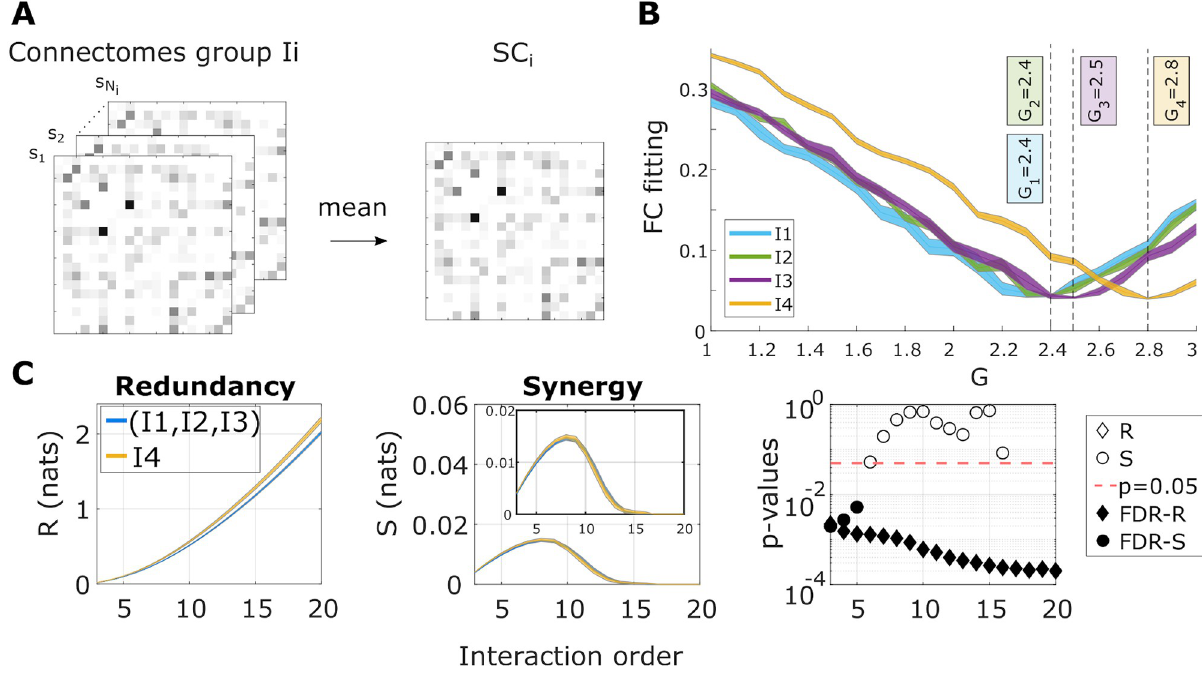
Fig 2. The DMF model reproduces the statistically significant differences in the high-order interactions of redundancy. A : First, the within age- group average SC matrix was calculated. B : Next, the optimal G value for each group was obtained. C : We simulated brain activity within each group using the average SC and the corresponding optimal G i , computed the O-information as a function of the interaction order, and separated sets of elements into the dominantly redundant (positive O-information values) and synergistic (negative O-information values). Here, the total redundancy (R) and synergy (S) was obtained as the average O-information over the redundant and synergistic sets, respectively. The p-values of the Wilcoxon rank-sum test are also depicted as a function of the interaction order, after comparing the values in I4 versus the ones obtained from the combination of (I1, I2, and I3). When the value of redundancy (or synergy) survived the false discovery rate (FDR) correction, the diamonds (or circles) were